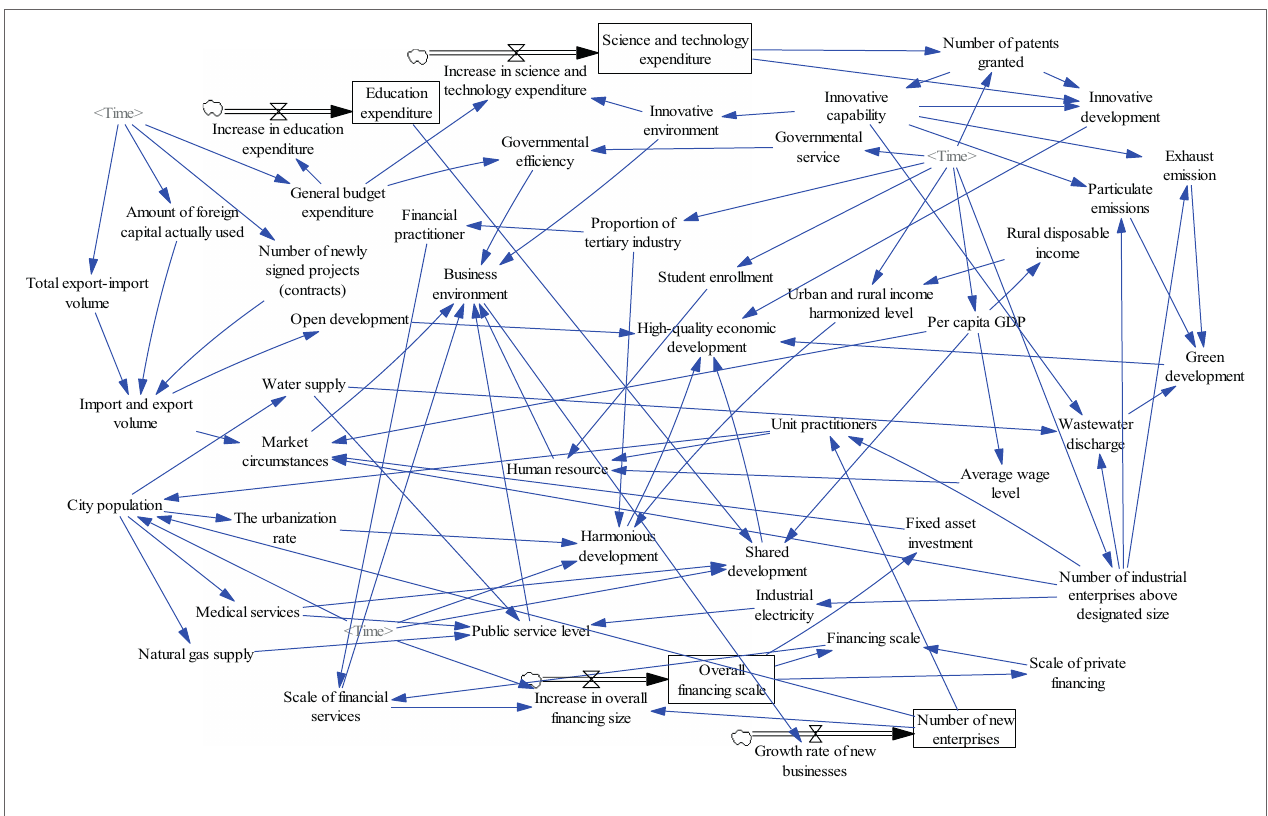
FIGURE 6 | General system structure flow